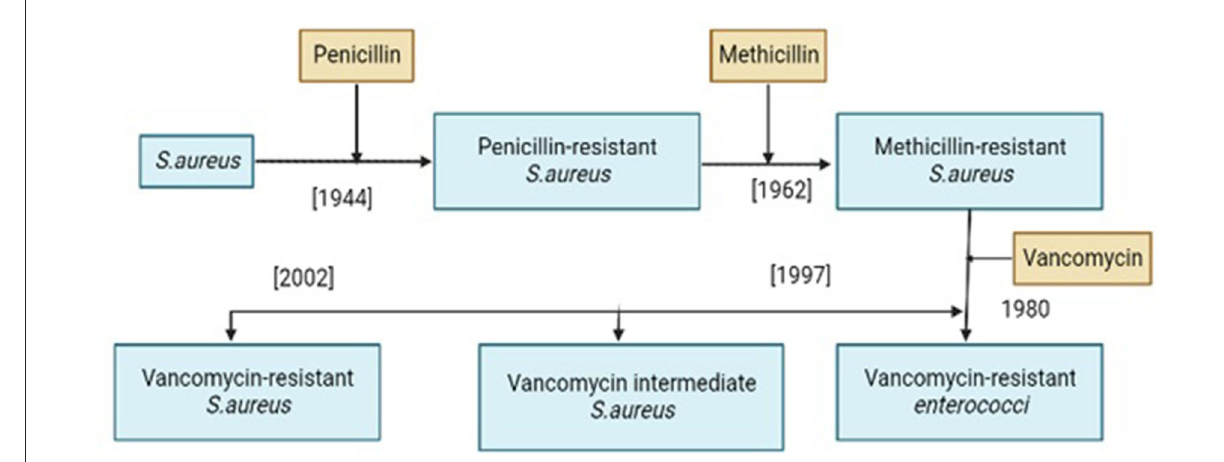
FIGURE1 History of resistance development in Staphylococcus aureus against different antibiotics.